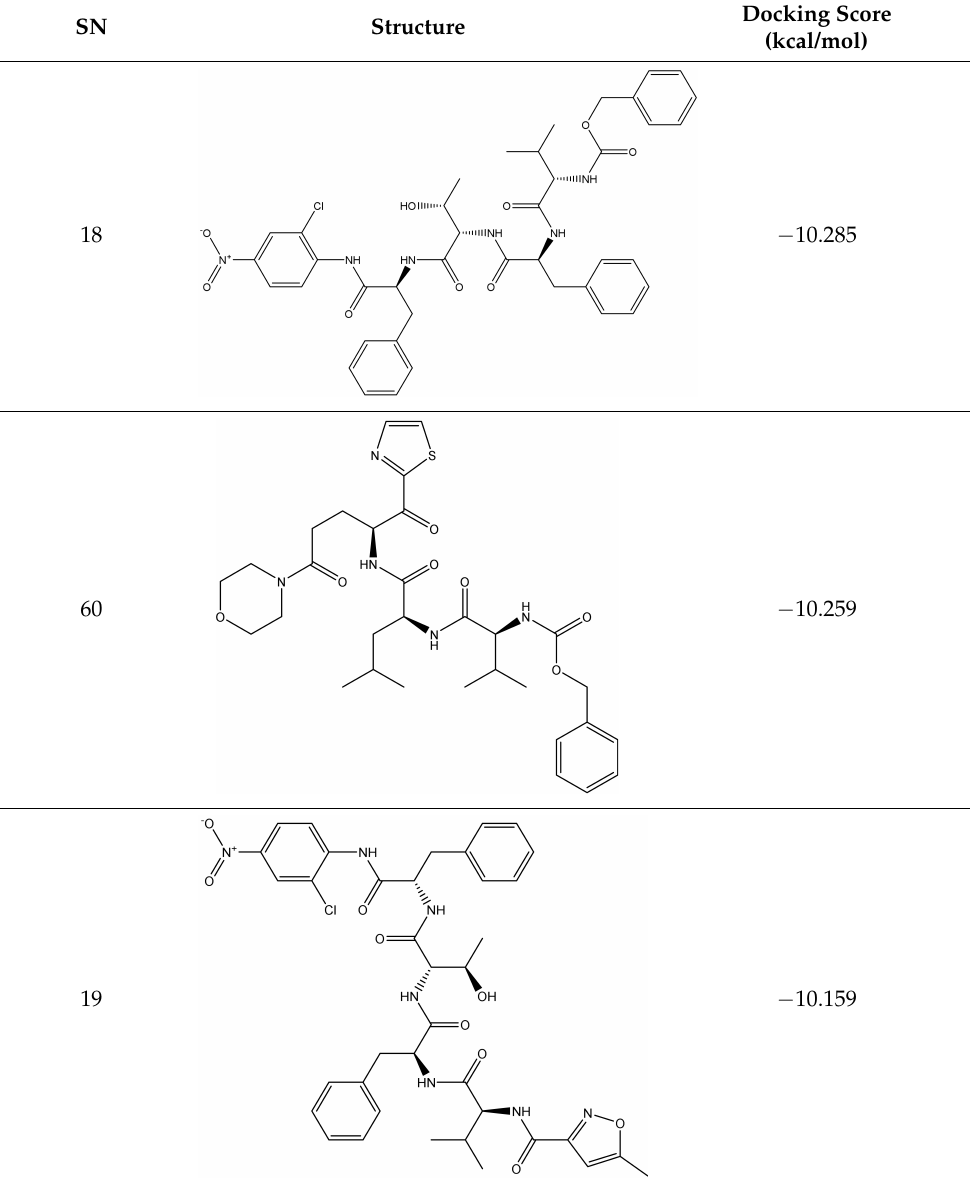
Table 3. Structures and docking score for molecules having higher docking score in the present